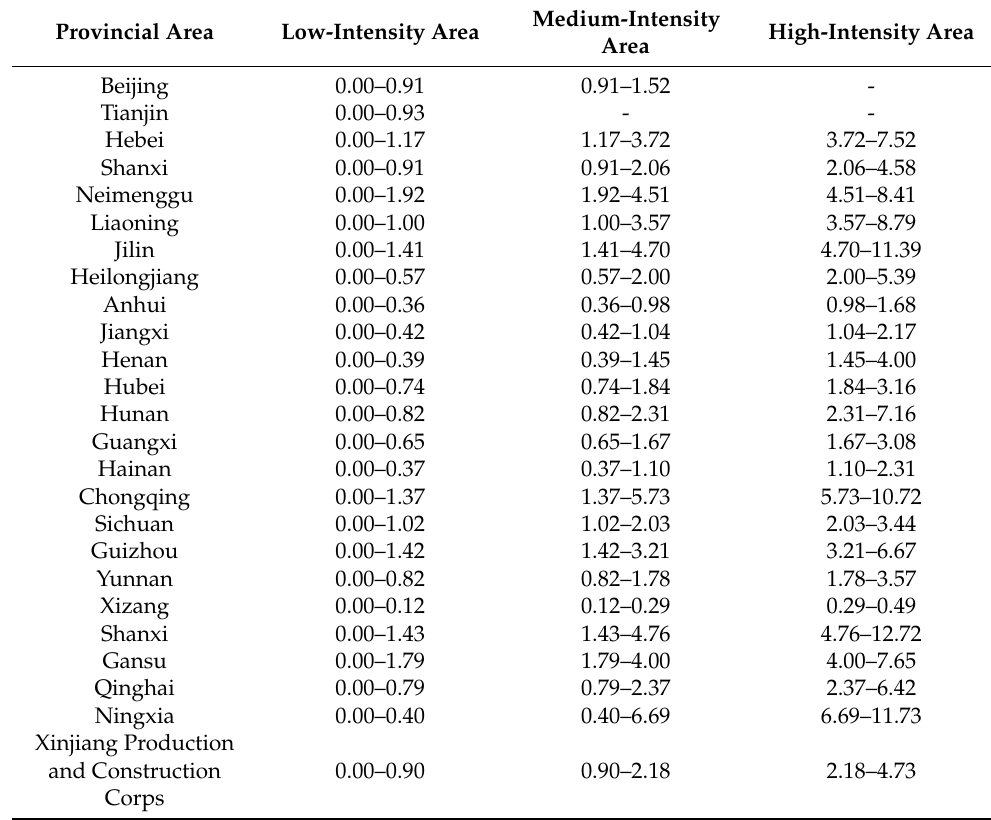
Table 2. Area intensity classification of the Grain for Green Project at the provincial level (unit: 10 4